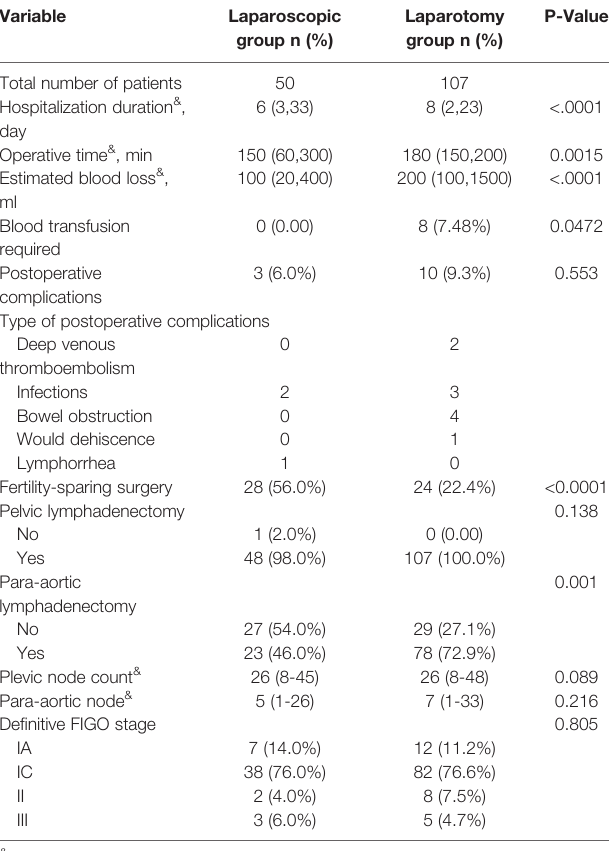
TABLE 2 | The surgical outcomes of patients.